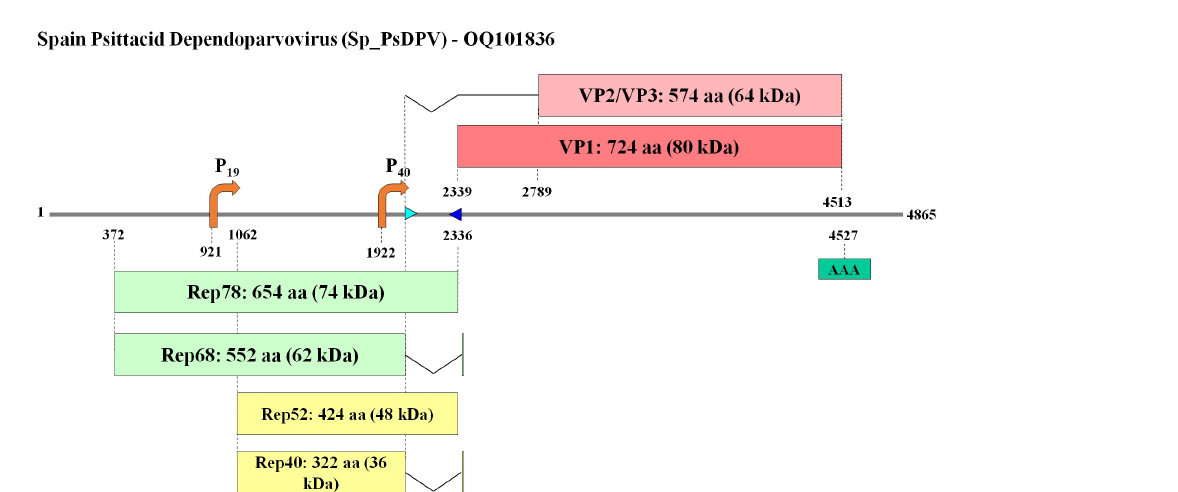
Figure 2. Genomic organization of Anseriform Dependoparvovirus 1 (25749), Avian Dependopar- vovirus 1 (AY186198), and the dependoparvoviruses isolated from Psittacidae (Sp_PsDPV and Ch_PsDPV). The numbers shown under the bars that represent the genomes correspond to the nt position. The promoters of Ch_PsDPV were named P A ∼ P 19 (Promoter A, such as P 19 ) and P B ∼ P 40 (Promoter B, such as P 40